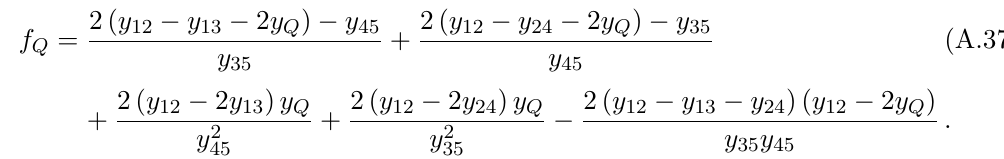
2 [75 ; 105] GeV, b (cid:22) b ) corrections, while s